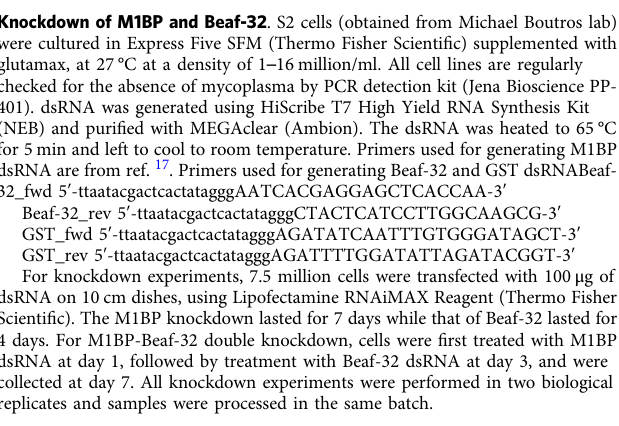
Code availability . HiCExplorer code is available online at: https://github.com/ deeptools/HiCExplorer/. HiCBrowser code is available at: https://github.com/